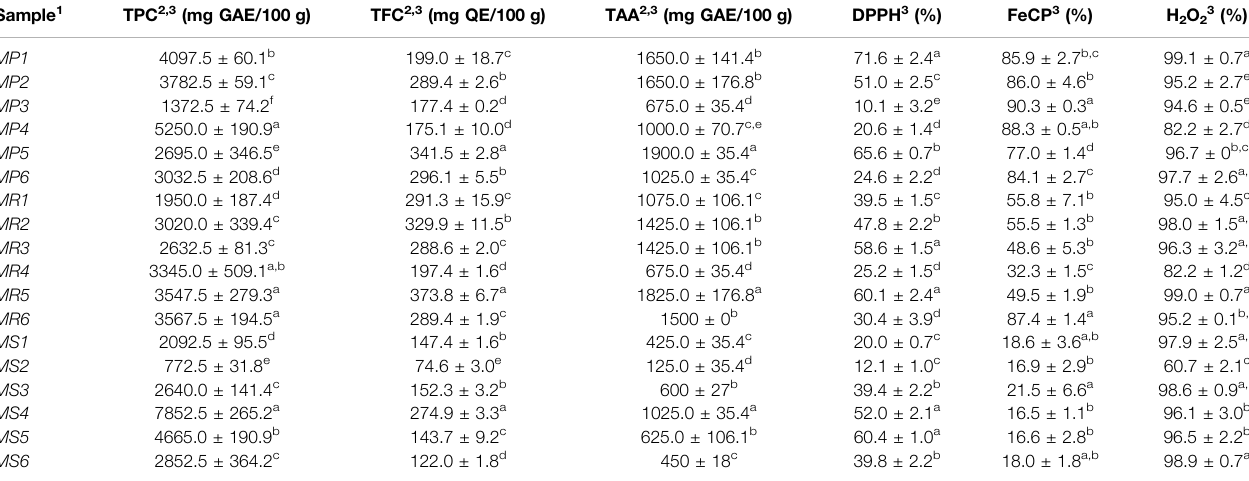
radical scavenging activity, iron chelating power (FeCP), and